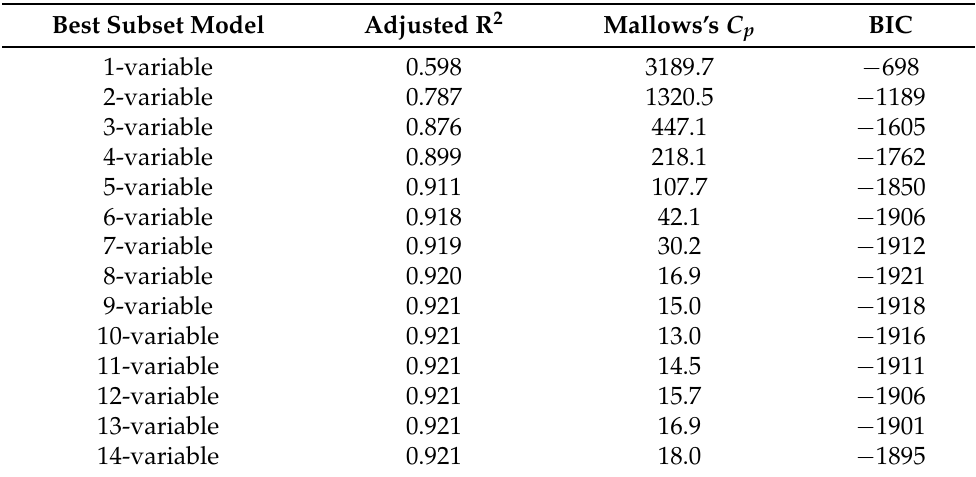
Table 4. Adjusted R 2 , Mallows’s C p , and BIC values of the best subset models from Table